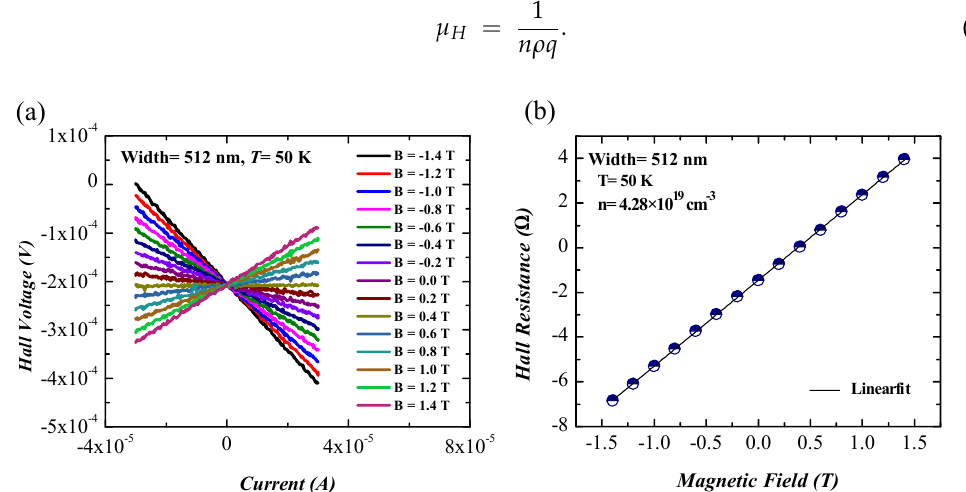
Figure 6. ( a ) Hall voltage–current curves at different magnetics fields; ( b ) Hall resistance as a function of magnetic field for GeNW with an average width of 512